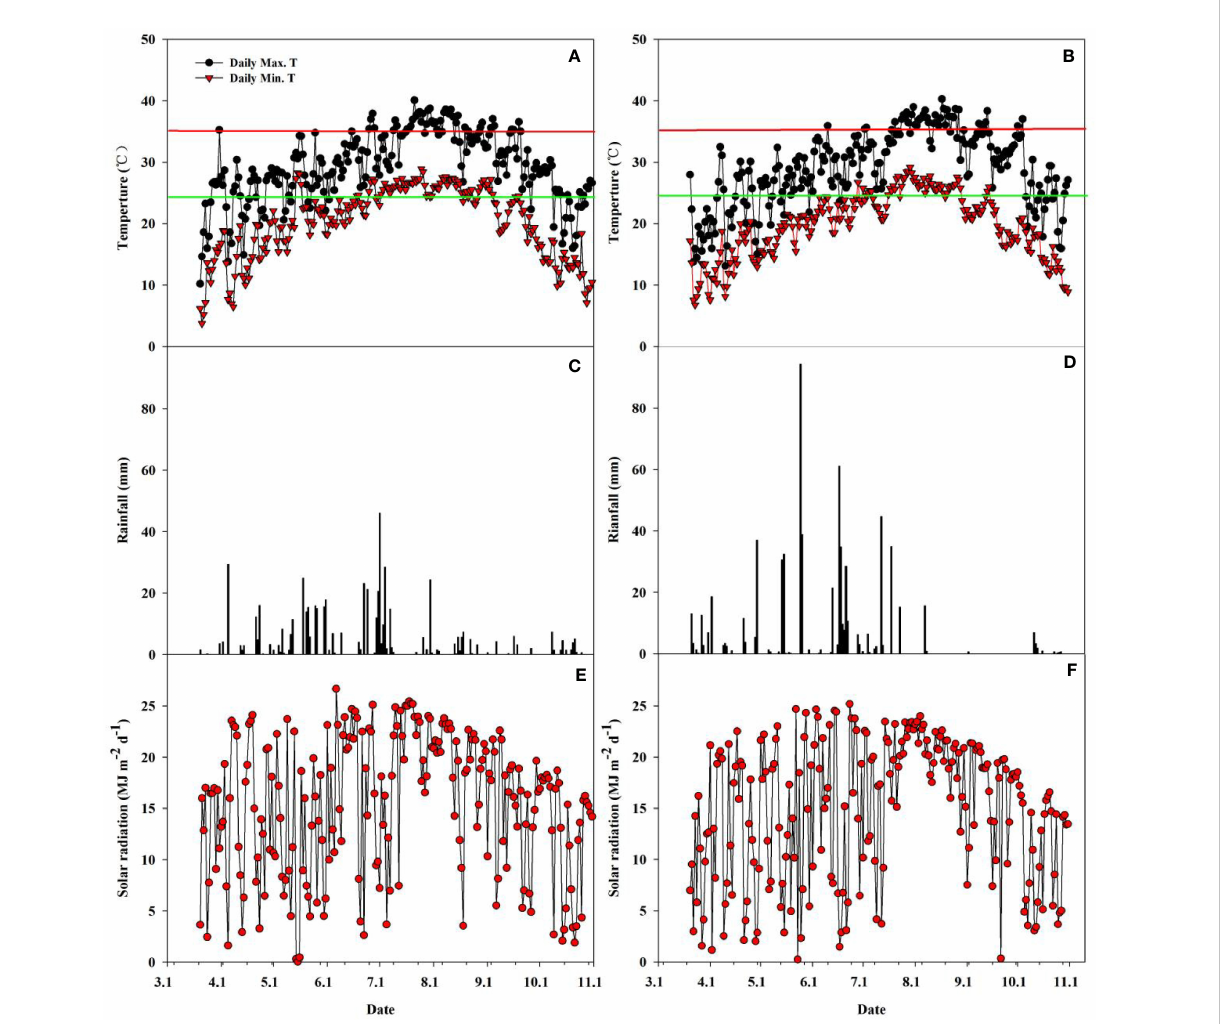
FIGURE 2 Daily minimum and maximum temperature (A, B) , rainfall (C, D) , and solar radiation (E, F) during the rice-growing season from seeding to maturity of ratoon crop at Qichun County, Hubei Province, China in 2018 (A, C, E) and 2019 (B, D, F) . Red horizontal lines in Figures 1A, B represent a critical temperature of 35°C; Green horizontal lines in Figures 1A, B represent the average temperature during the whole growth